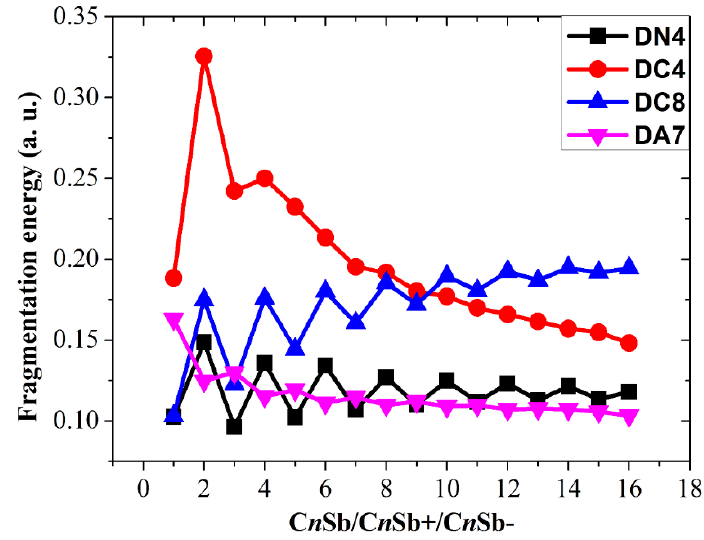
Figure 18. The most favorable dissociation channels for C n Sb/ C n Sb + / C n Sb −